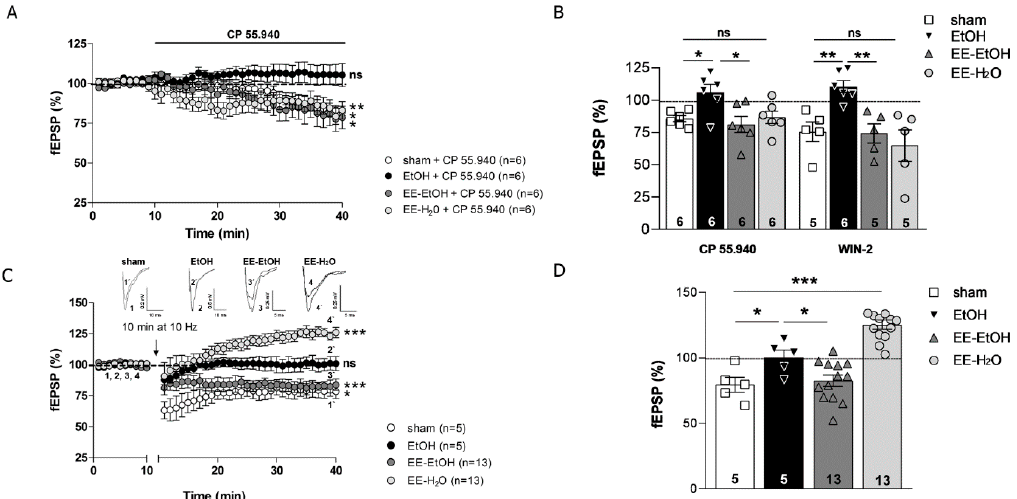
Figure 3. EE recovers CB1R-mediated excitatory transmission and MPP-LTD impaired by EtOH intake during adolescence. EE in young adult brain leads to MPP-LTP. ( A ) CP 55,940 (10 μ M, white circles) reduces fEPSPs in sham but not in EtOH-treated mice (black circles). EE recovers the fEPSPs impaired by EtOH intake during adolescence (dark grey circles). CP 55,940 (10 μ M, light grey circles) depresses fEPSPs in EE-H 2 0. Data are expressed as mean ± SEM. Student’s t-test, p > 0.05 (ns = not significant); * p ≤ 0.05; ** p ≤ 0.01 vs. baseline. ( B ) Summary bars: sham + CP 55,940 (10 μ M), EtOH + CP 55,940 (10 μ M), EE-EtOH + CP 55,940 (10 μ M), EE-H 2 O + CP 55,940 (10 μ M); sham + Win-2 (5 μ M), EtOH + Win-2 (5 μ M), EE-EtOH + Win-2 (5 μ M), EE-H 2 O + Win-2 (5 μ M). Numbers in the bars are individual experiments. Data are expressed as mean ± SEM. One-way ANOVA, p > 0.05 (ns = not significant); * p ≤ 0.05; ** p ≤ 0.01. ( C ) Up; superimposed traces (average of 10 consecutive fEPSPs taken at the time indicated on the time course) showing the effect after LFS (10 min, 10 Hz). Down; LFS triggers MPP-LTD in sham (white circles) but not in EtOH (black circles). EE-EtOH rescues MPP-LTD (dark grey circles) and LFS leads to MPP-LTP in EE-H 2 0 (light grey circles). Data are expressed as mean ± SEM. Student’s t-test, p > 0.05 (ns = not significant); * p ≤ 0.05; *** p ≤ 0.001 vs. baseline. ( D ) Summary bar graph of MPP-LTD and MPP-LTP experiments: sham, EtOH, EE-EtOH, and EE-H 2 0. Numbers in the bars are individual experiments. Data are expressed as mean ± SEM. One-way ANOVA, * p ≤ 0.05; *** p ≤